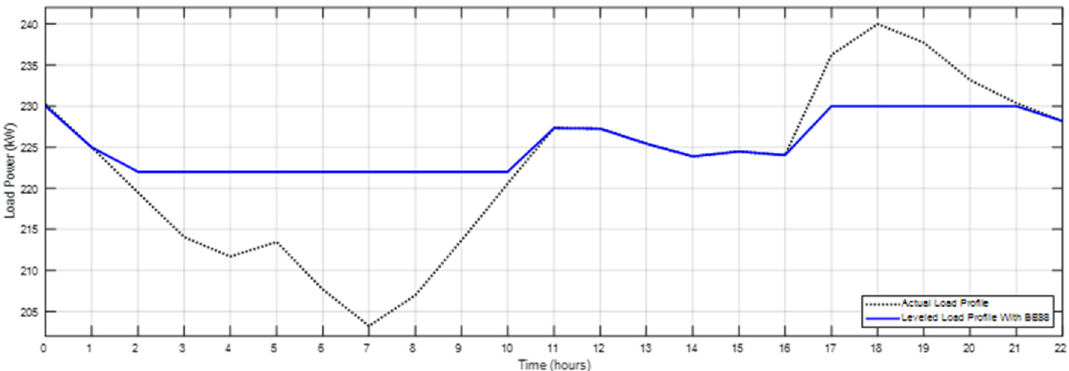
Figure 13. Distributed Case: Minimum Individual Bus-load profile with/without a BESS.